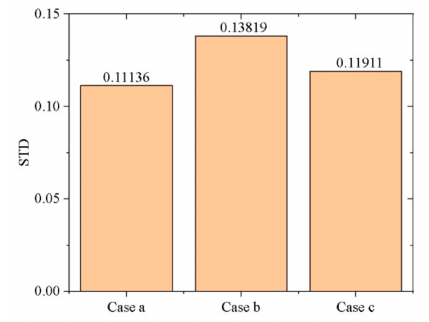
Figure 15. STDs of Case a, Case b, and Case